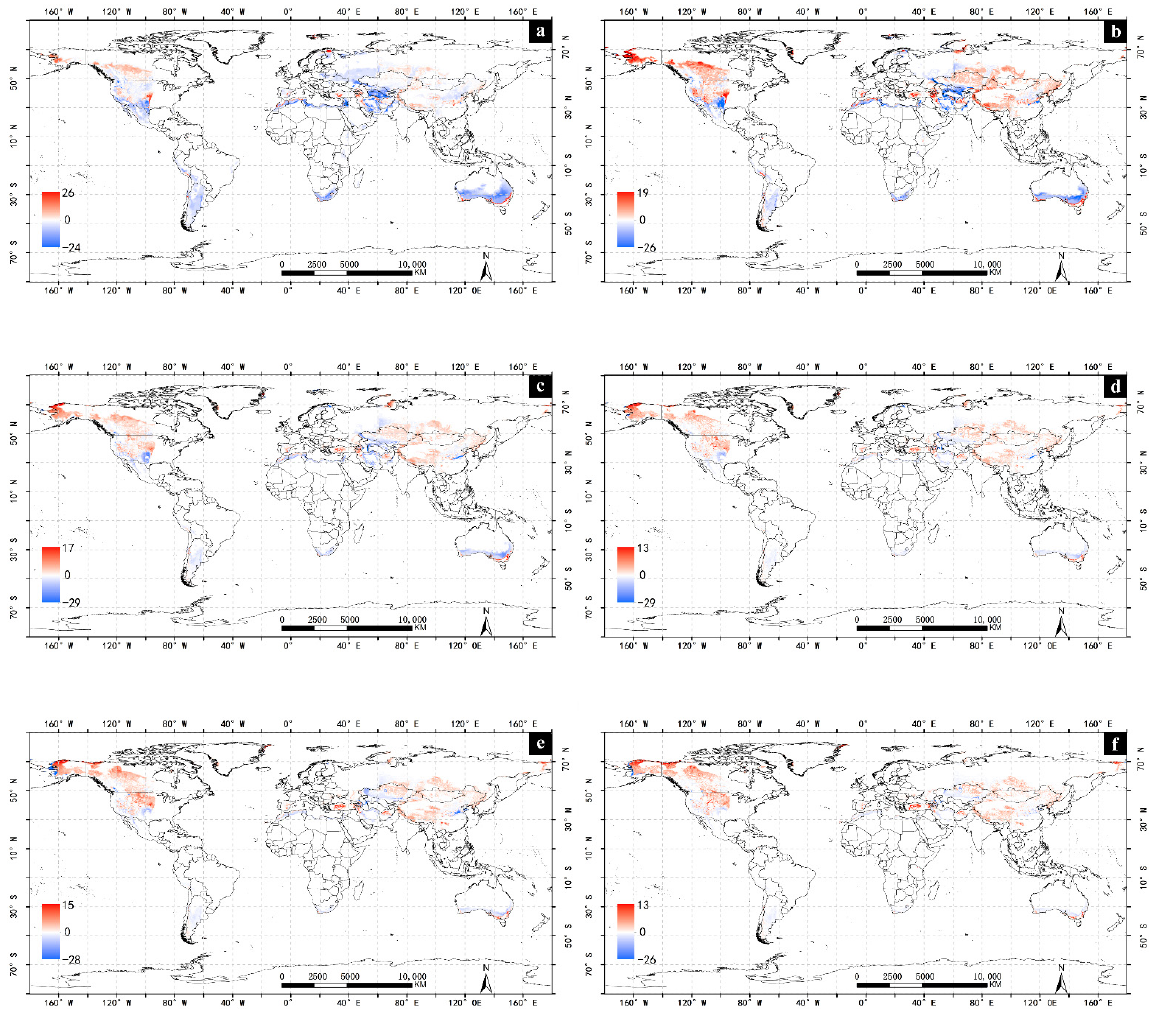
Figure 6. EI difference map of Apocheima cinerarius in different periods in the world: ( a ) 2030–1975; ( b ) 2050–2030; ( c ) 2070–2050; ( d ) 2080–2070; ( e ) 2090–2080; ( f ) 2100–2090.